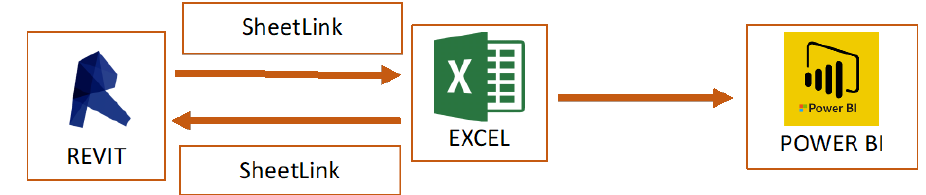
Figure 5. Information exchange and update scheme.